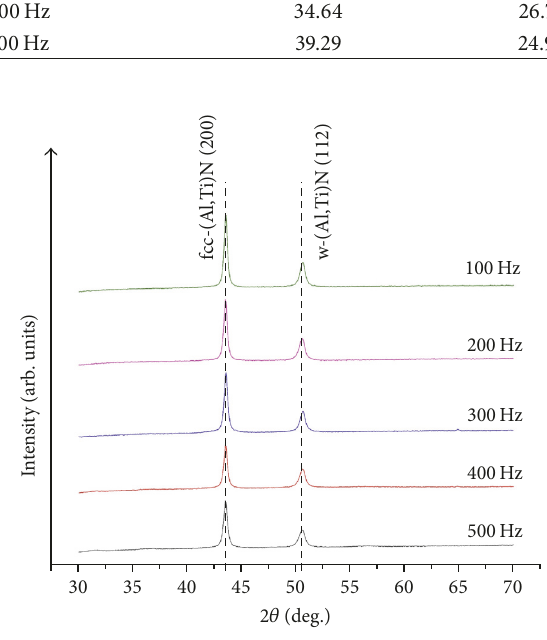
Figure 5: 2-theta XRD-measurements of fcc- and w-AlTiN phases of AlTiN coatings by HPPMS with various pulse-frequency in the range of 100–500